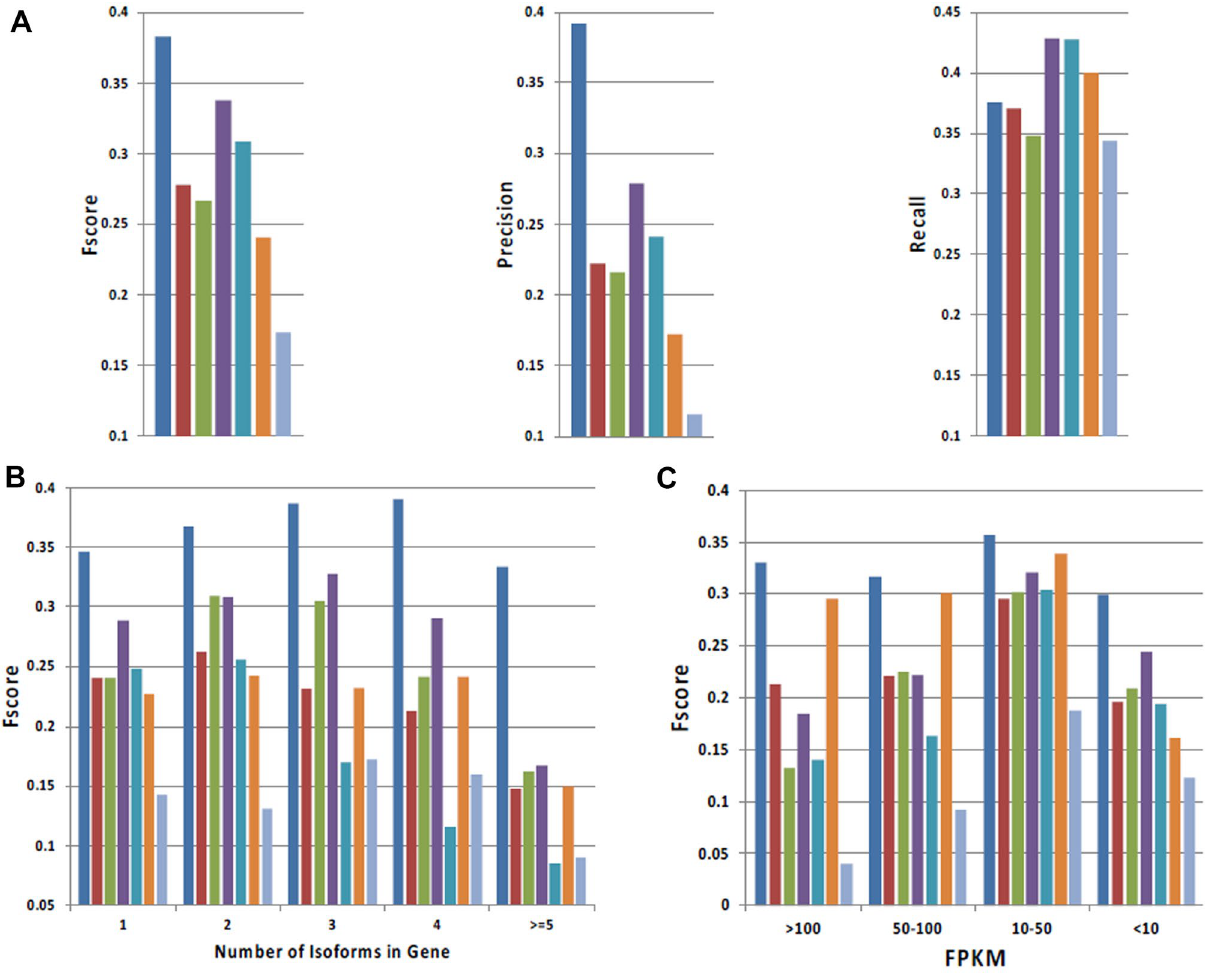
Figure 1. Performance comparison on transcript assembly using simulated data. (A) Overall performance evaluated by F-score, Precision and Recall. (B) Performance on subsets of genes grouped by the number of isoforms. (C) Performance on subsets of transcripts grouped by expression